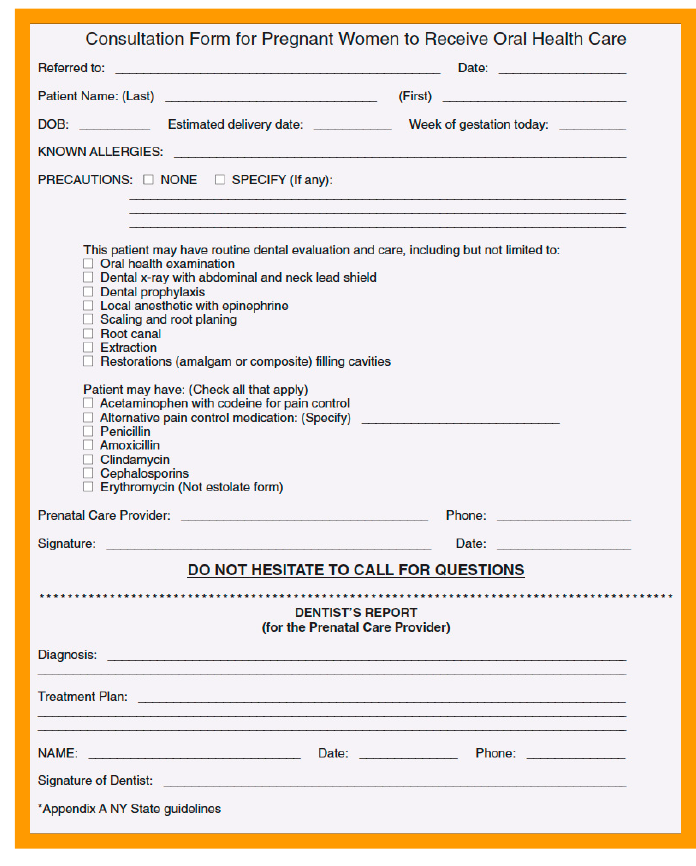
Figure 2. Dental referral form.